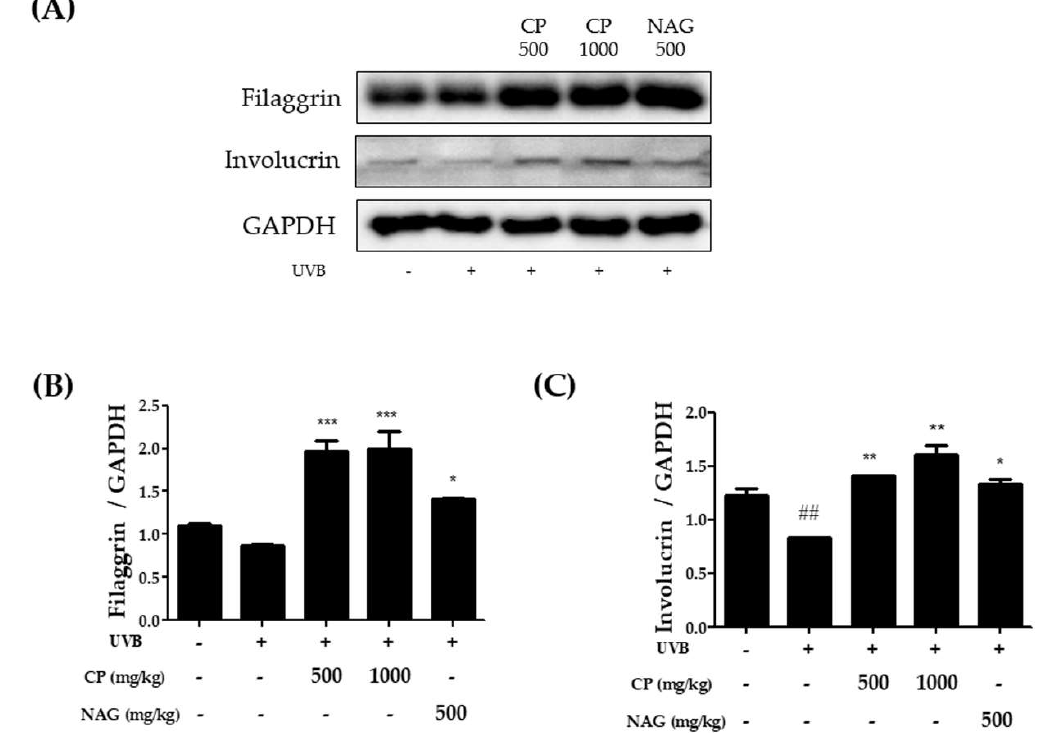
Figure 3. Effect of oral administration of collagen peptide on the expression of filaggrin and involucrin in the dorsal skin of UVB-irradiated mice. ( A ) Western blotting and ( B , C ) relative densities of filaggrin and involucrin. The values are shown as mean ± SEM ( n = 8). ## p < 0.01 (vs. control mice). * p < 0.05, ** p < 0.01, and *** p < 0.001 (vs. UVB-irradiated mice).